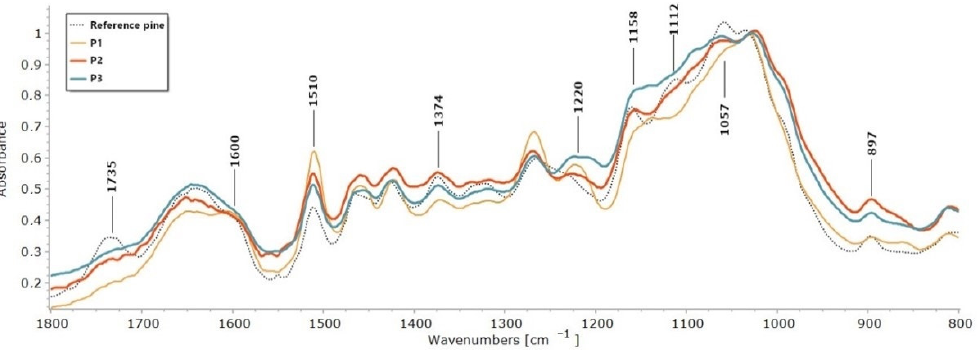
Figure 1. FTIR spectra of archaeological pine wood samples and reference pine wood sample.